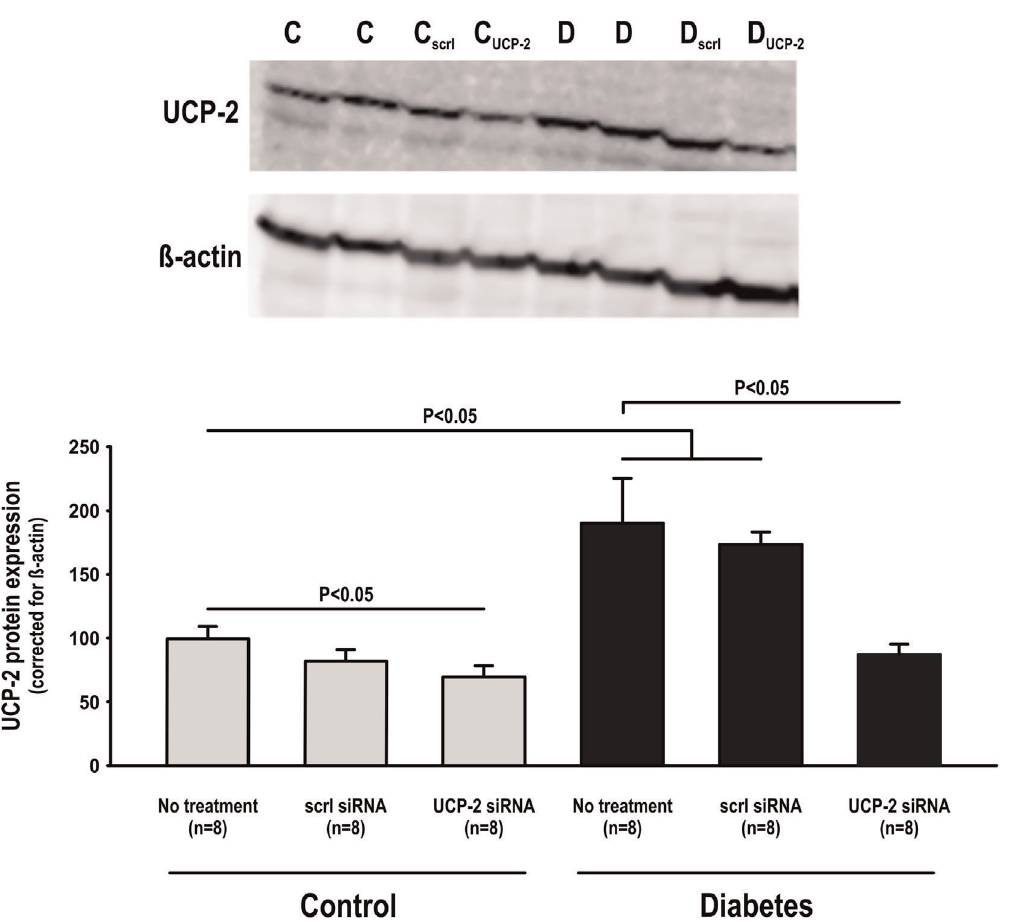
Figure 1. UCP-2 protein expression in control and diabetic animals with and without scramble or UCP-2 siRNA administration. A representative blot is displayed on the top.